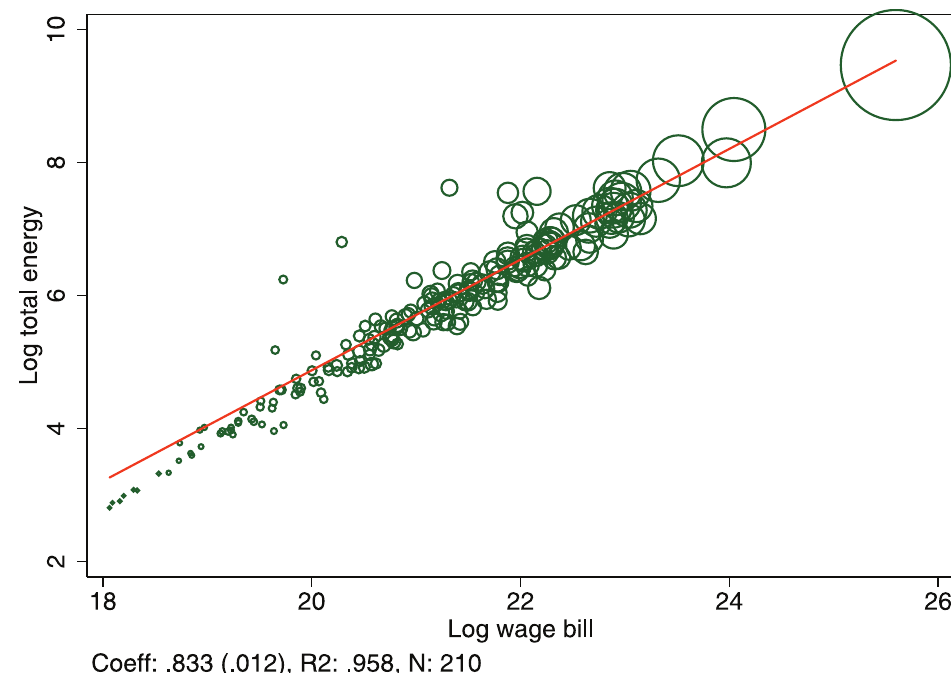
Fig 2. Urban energy premium. Total energy demanded and its scaling with respect to total wage bill. Each dot represents a UK Travel to work area. The share of total energy demand is 33% for Households, 29% for Transport, and 38% for Industry. The scaling coefficient was estimated by OLS and the standard error is shown in